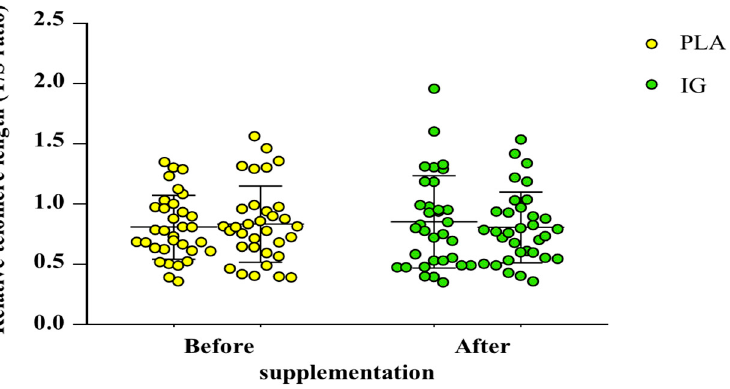
Figure 5. Blood leukocyte relative telomere length (RTL) of the participants before and after supple- mentation phase (n = 33 each group). Abbreviations: PLA, placebo; IG, Irvingia gabonensis.